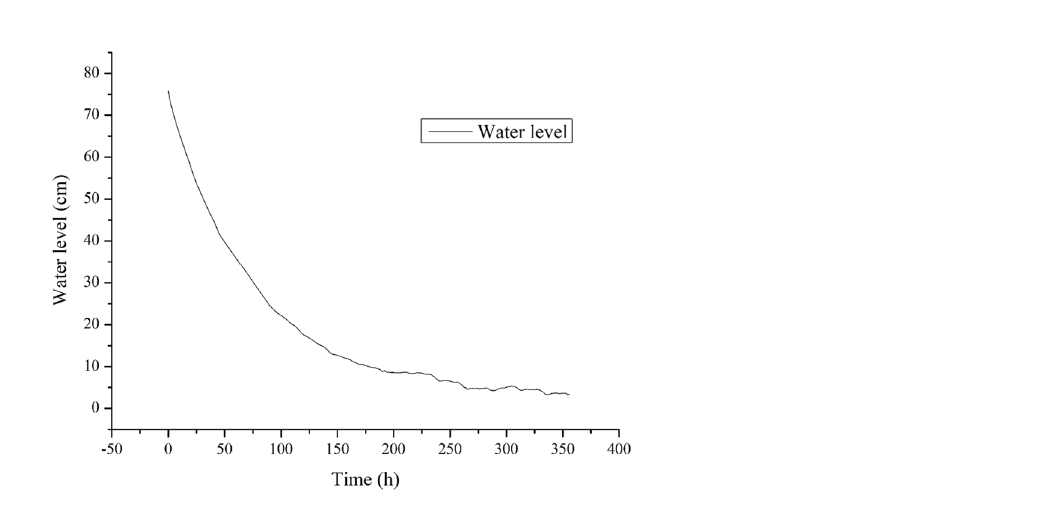
Figure 9. Water level in Mariotte’s